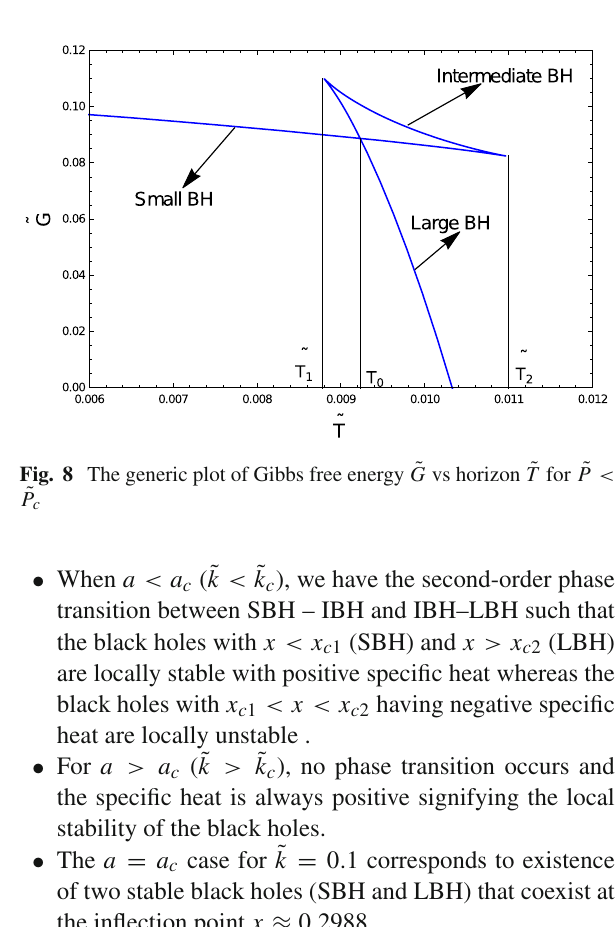
Fig. 7 The plot of specific heat ˜ C P vs horizon x + for different values of parameter a and NED parameter ˜ k